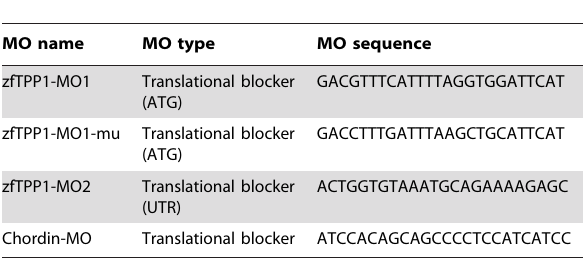
Table 1. Morpholino oligonucleotides used in this study. Table 2. Primers used to identify zfTPP1, zfTIN2 and zfPOT1.